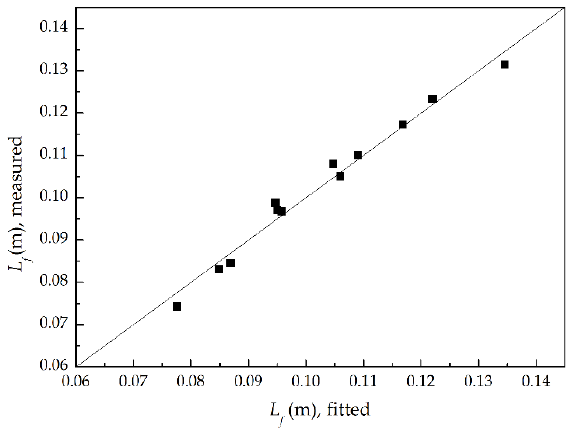
Figure 8. Prediction of flame length from its correlation.